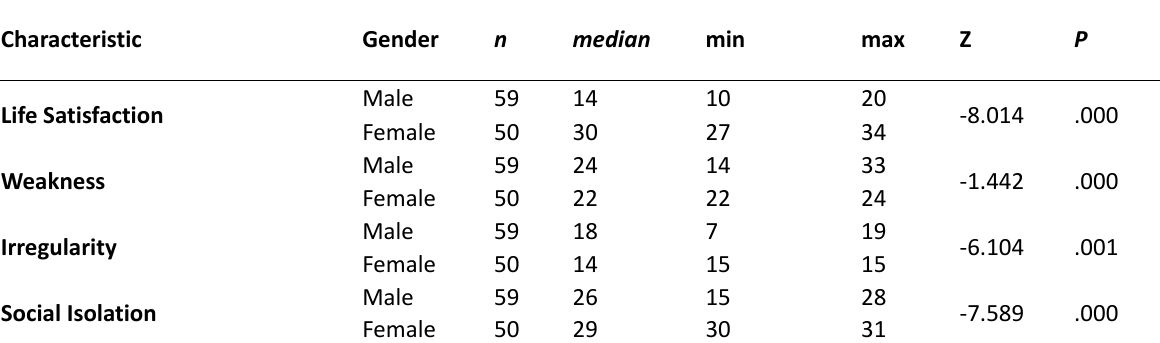
Table 4 indicates the comparison of life satisfaction scores and alienation level sub-dimension scores according to the marital status of the participants. A statistically significant difference was found between the participants’